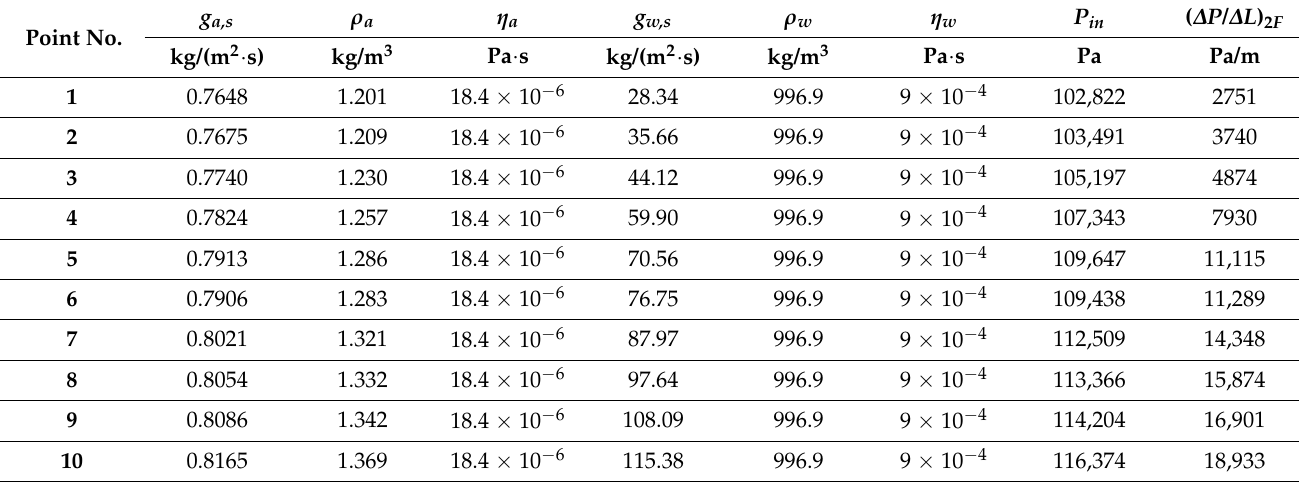
Table 2. Results of experimental measurements; T =